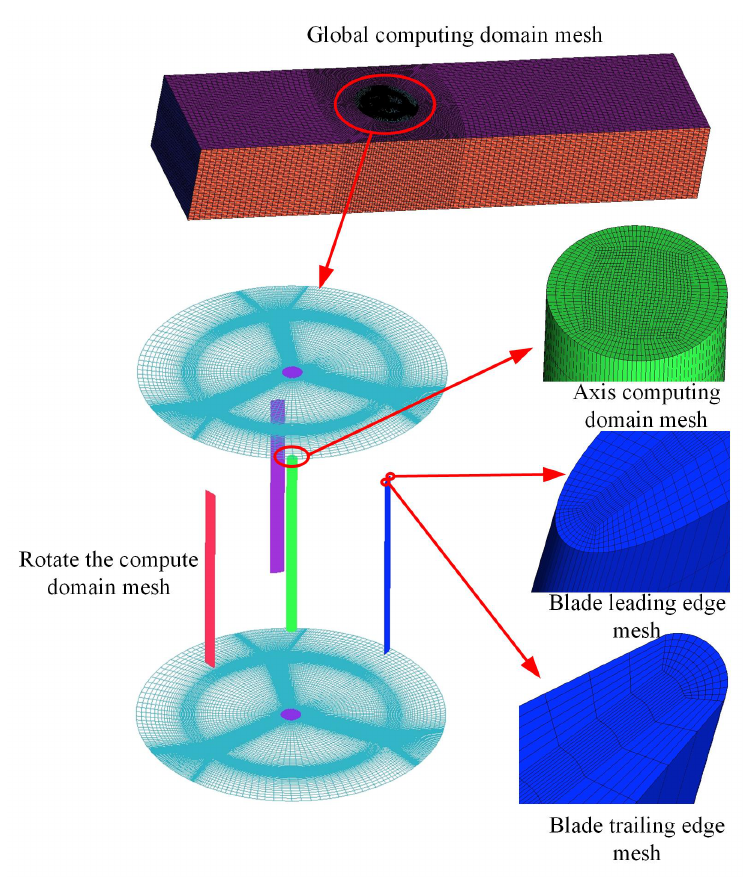
Figure 9. Three-dimensional computational